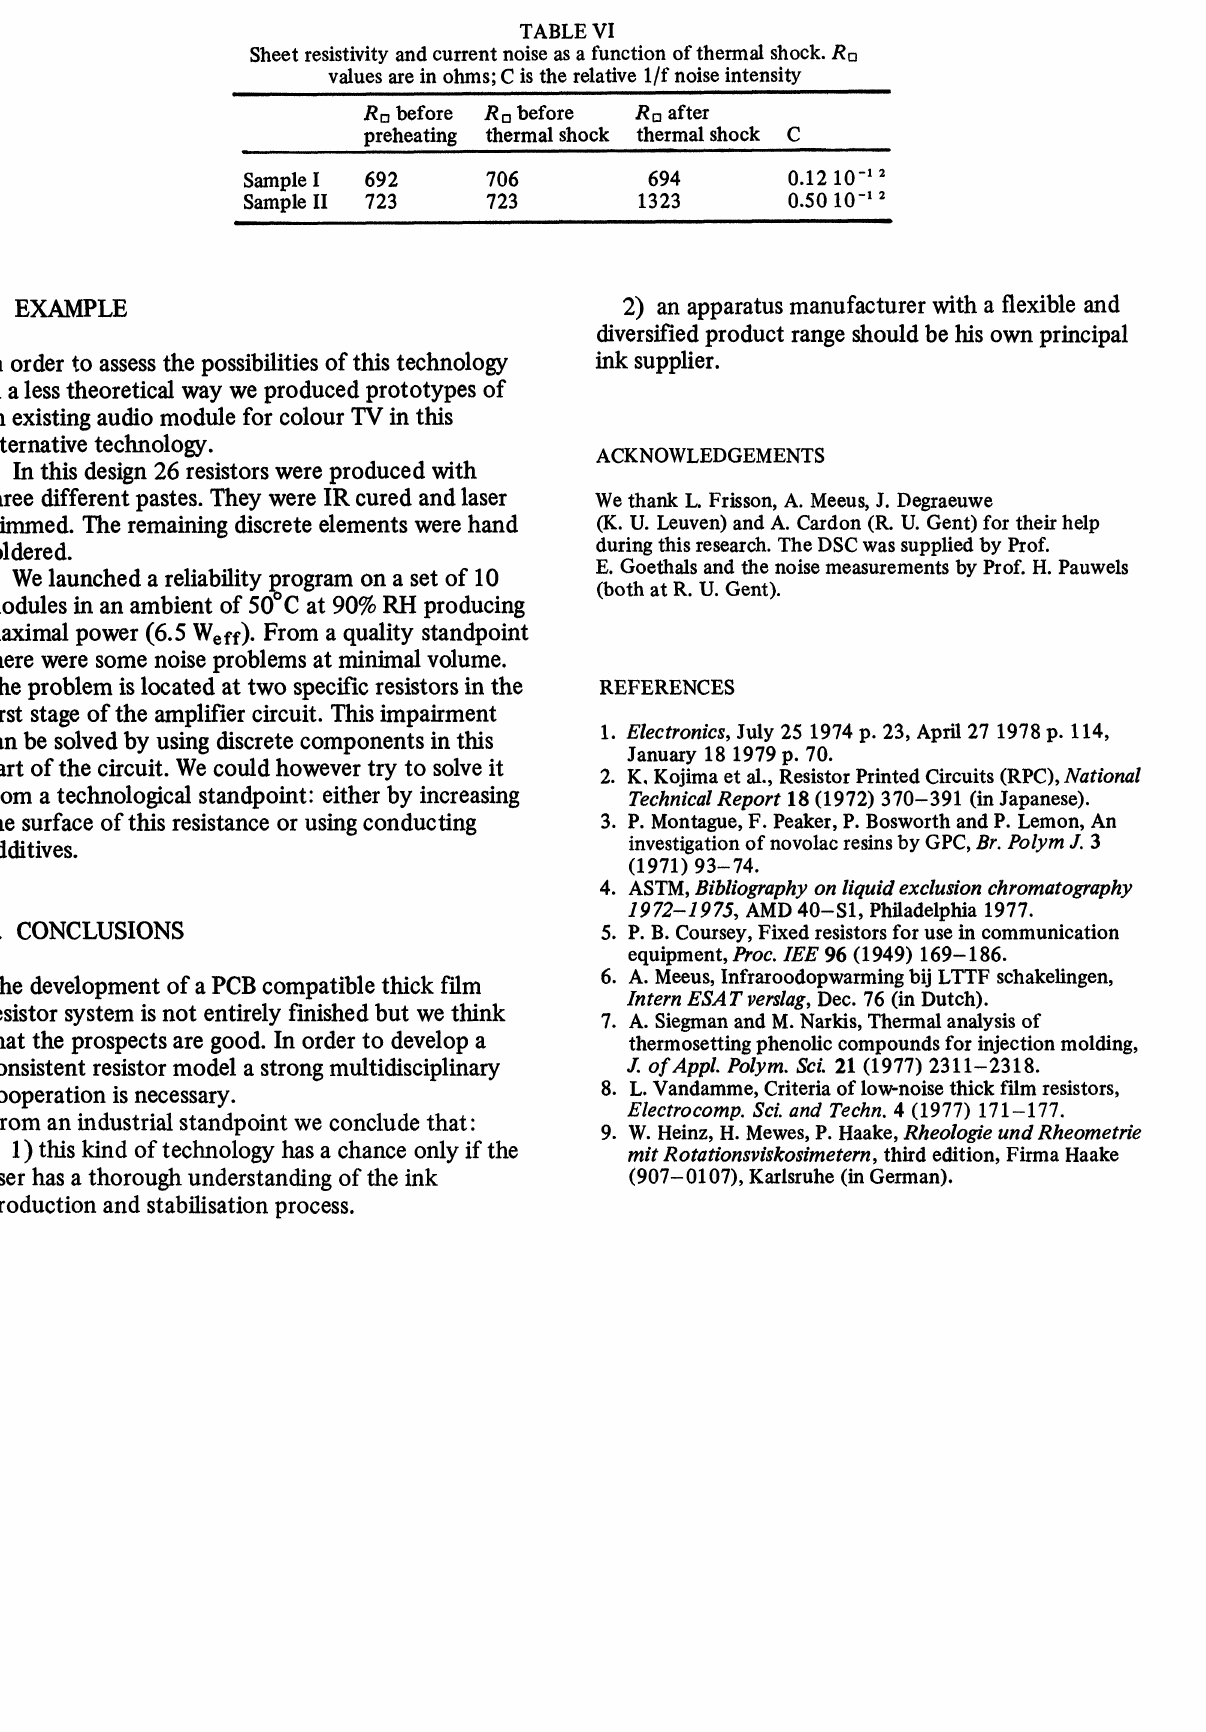
TABLE VI Sheet resistivity and current noise as a function of thermal shock.